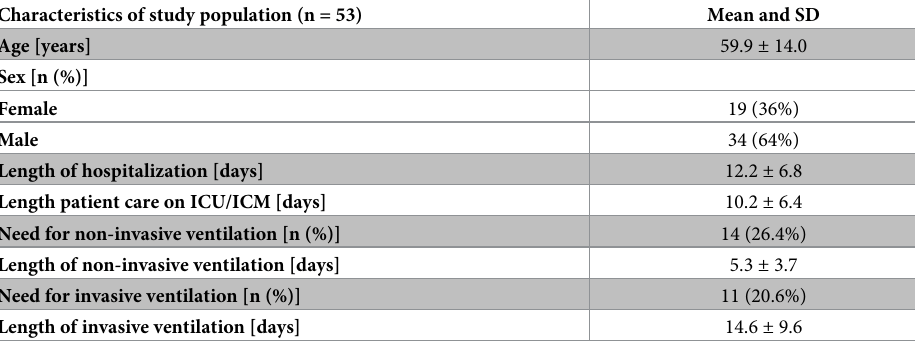
Table 1. Characteristics of study